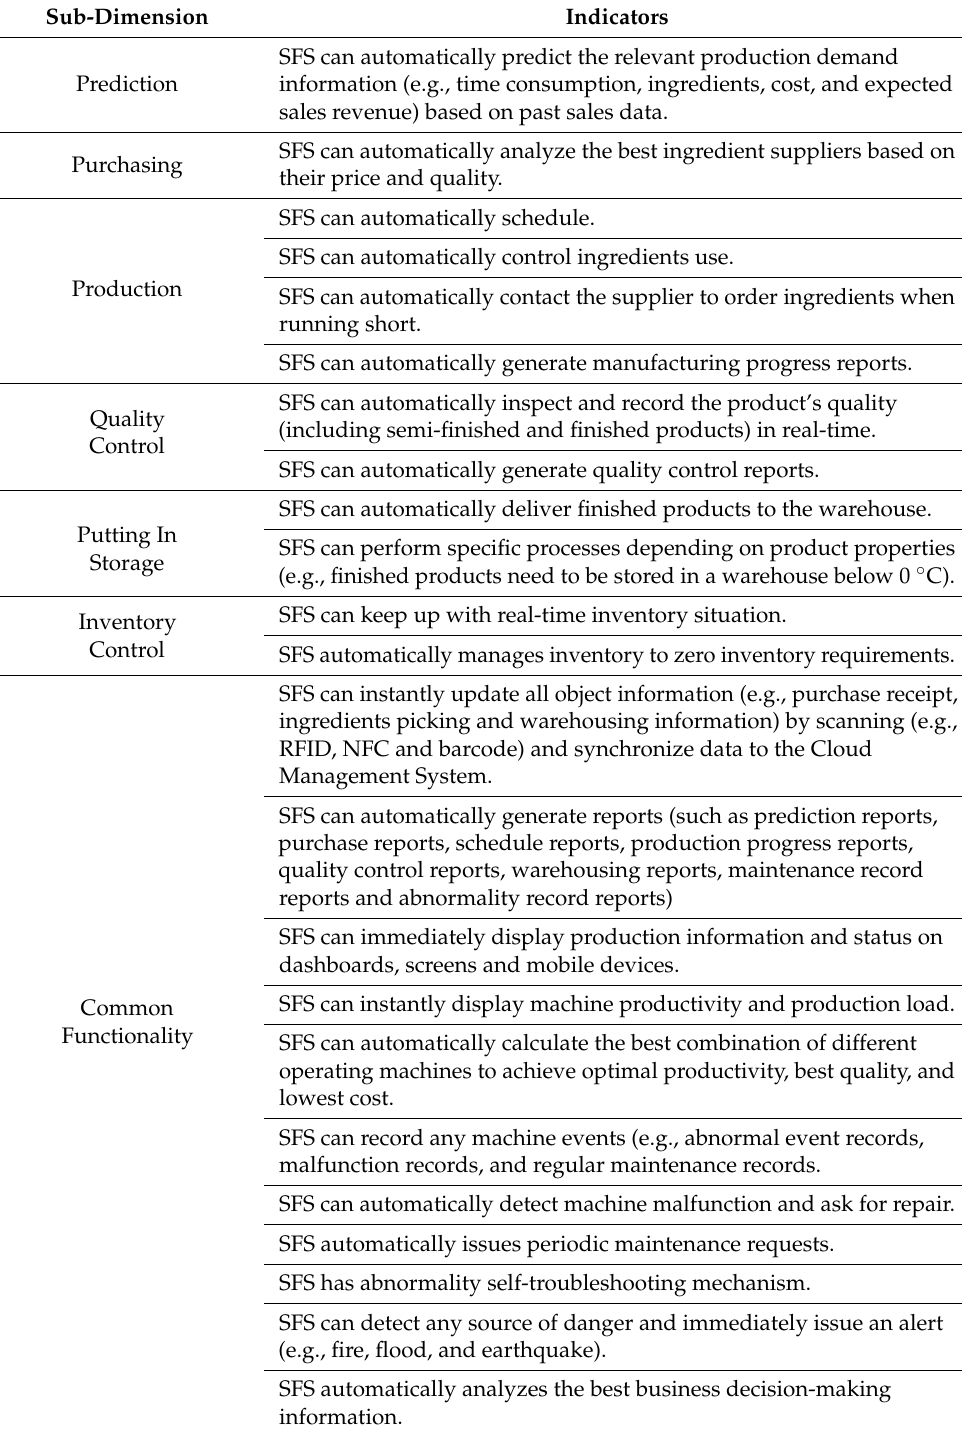
Table 4. Sub-dimensions and indicators of SFS function